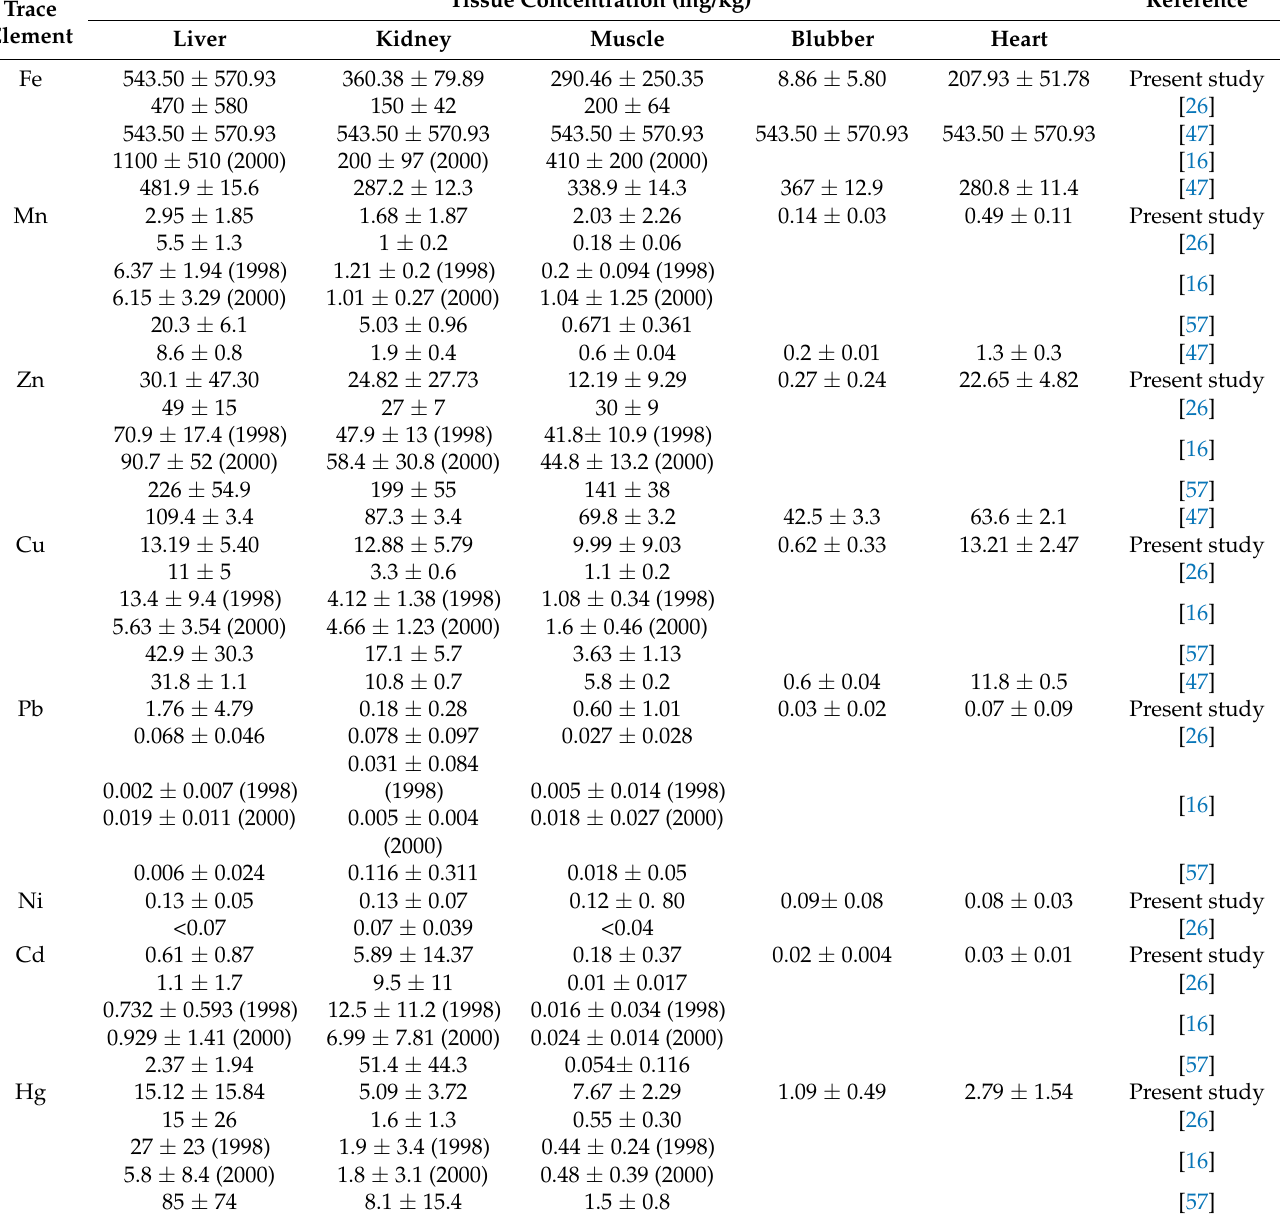
Table 4. Comparison of trace element concentrations in Caspian seal tissues collected in the present study and previous research (mg/kg w.w.). Data from Ikemoto and Ershova are expressed as mg/kg